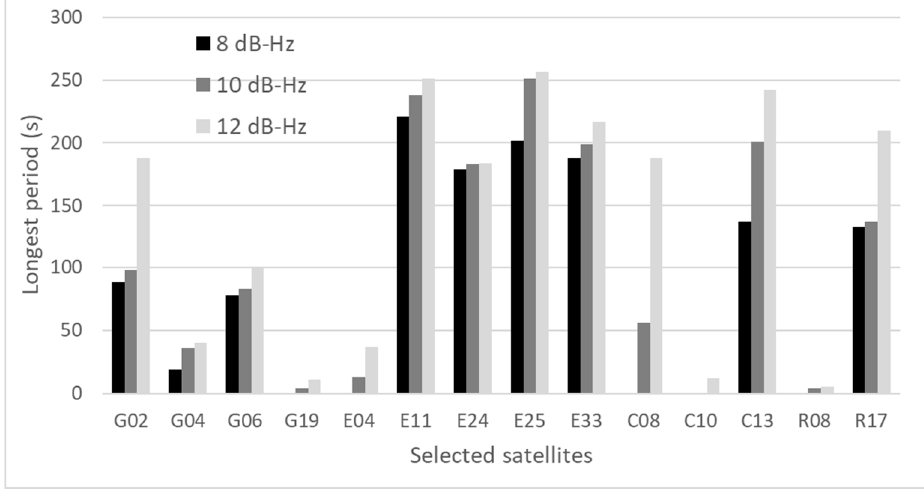
Figure 12. Longest period of selected satellites for three thresholds (medium-rise buildings).